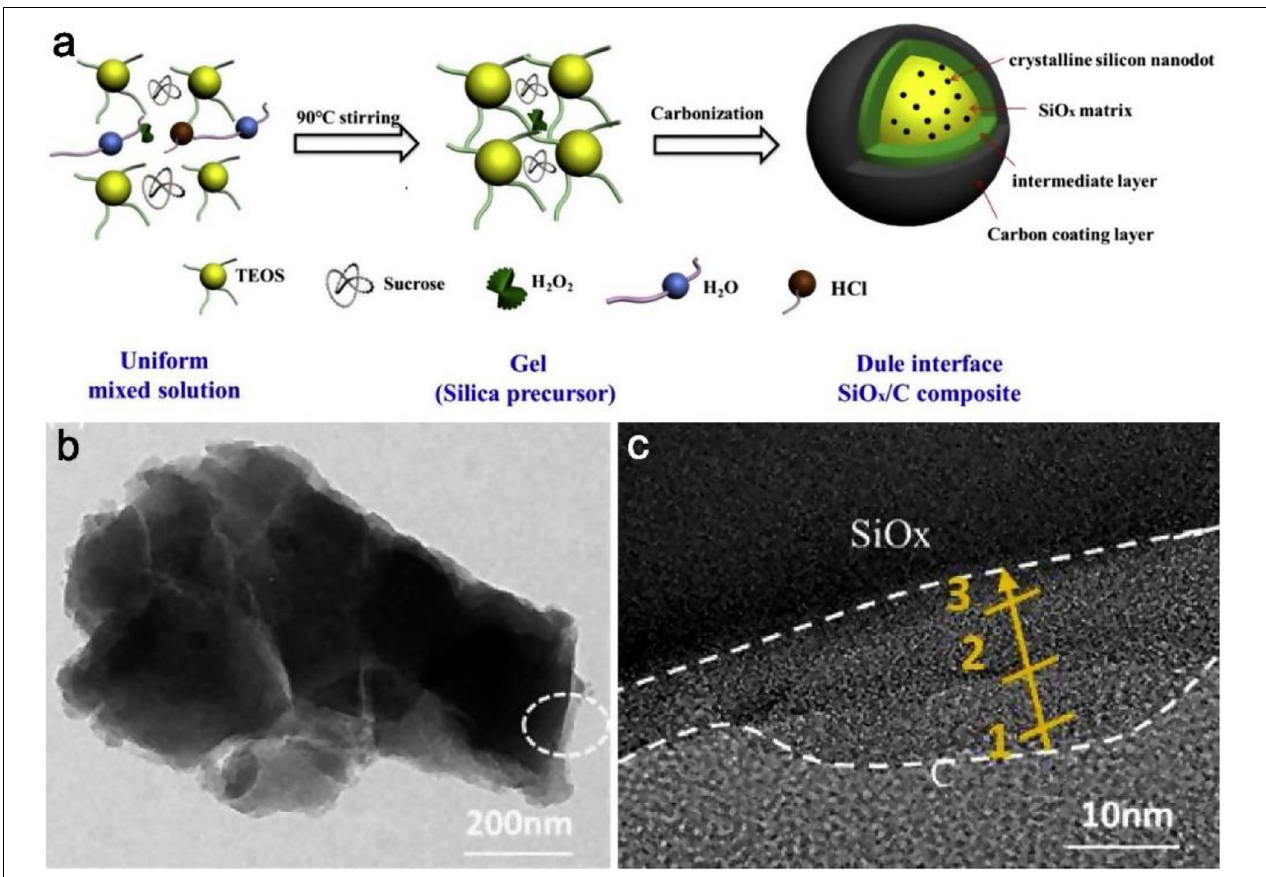
FIGURE 9 | The details for the preparation and structure of the dual interface SiOx/C composite. (a) Schematic illustration for the preparation of the SiOx/C composite. (b,c) TEM and HRTEM image of the double layer interface structure. Reproduced with permission from Ref. Liu Y. et al. (2019). Copyright 2019